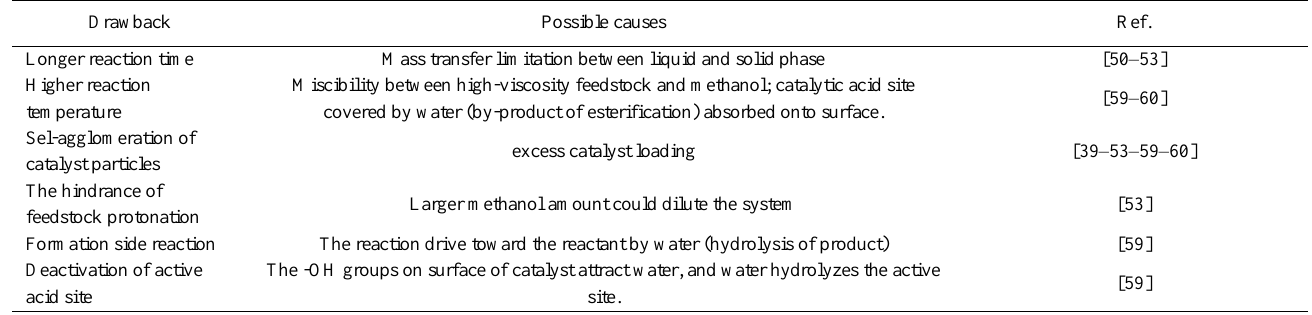
Table 2. The drawbacks and possible causes for the utilization of corncob-derived heterogeneous acid catalyst